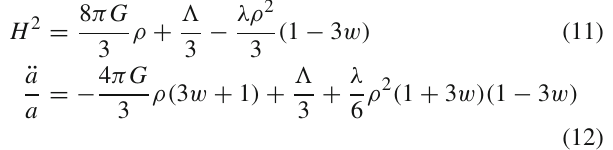
w . The horizontal